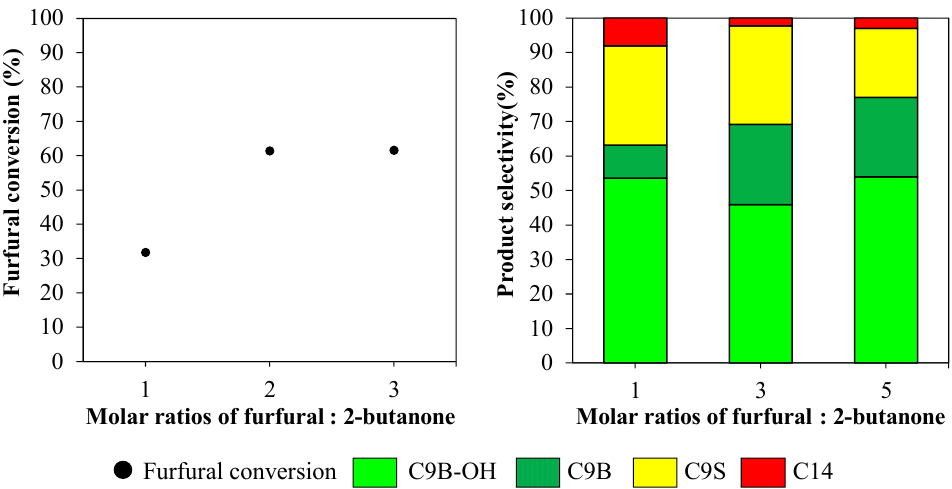
Figure 6. Effect of reactants molar ratio on furfural conversion and product selectivity obtained from aldol condensation of furfural and 2-butanone over LDO3 catalyst. (Reaction conditions: catalyst loading, 5 wt.%; time, 8 h; temperature, 80 °C; N 2 pressure, 10 bar).